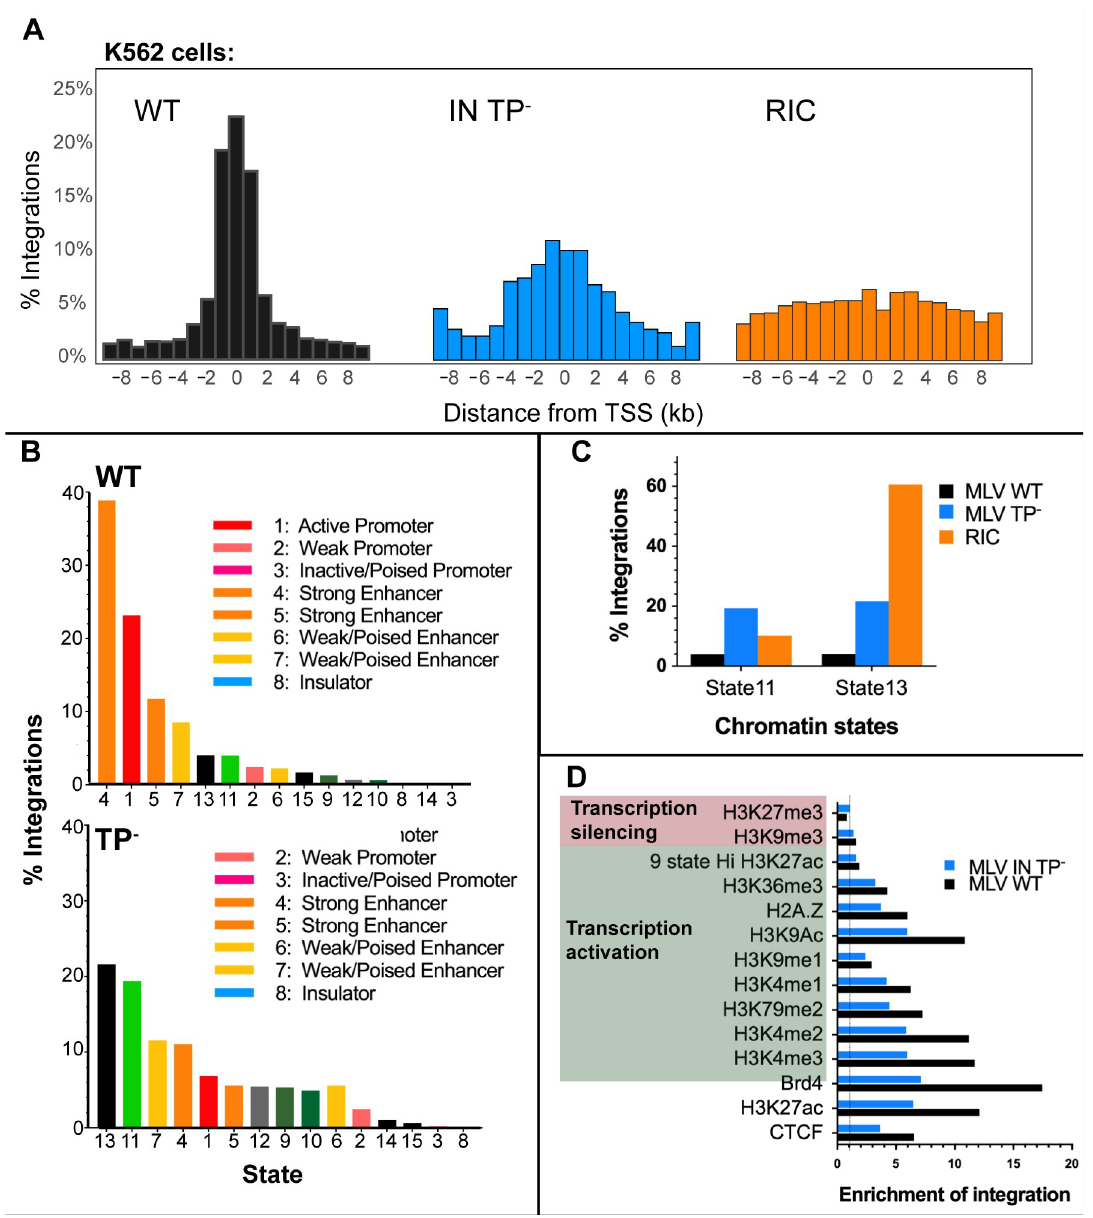
Fig 6. Analysis of IN TP - and WT MLV integration sites in K562 cells. (A) Histograms of MLV integration profile with respect to TSSs. (B) Percentage of RISs in 15-chromatin states [55] in K562 cells: WT (top panel) and IN TP - (bottom panel). Each chromatin state is labeled with corresponding color as indicated. (C) Percentage of RISs in state 11 and state 13 compared to RIC. State 11 is described as weakly transcribed regions and state 13 are heterochromatin regions [55]. (D) Enrichment of integrations in ChipSeq peaks of different histone marks and Brd4 binding regions in K562 cells. Value of enrichment is calculated by dividing the number of RISs with RIC values at each histone mark. The dotted line is the level of enrichment expected by chance. Transcription silencing histone marks are in pink and transcription activating marks are in